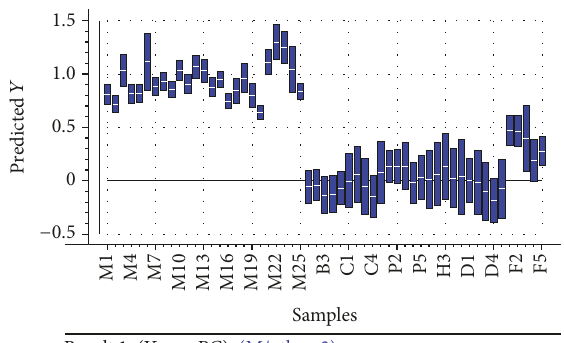
Figure 4: Discriminant results for validation set of samples by PLS- DA model. M1–M25, 25 mutton samples that did not participate in the modeling. The labels of 5 fraud samples and 25 other kinds of meat samples correspond to the code in Figure 3, but do not participate in the